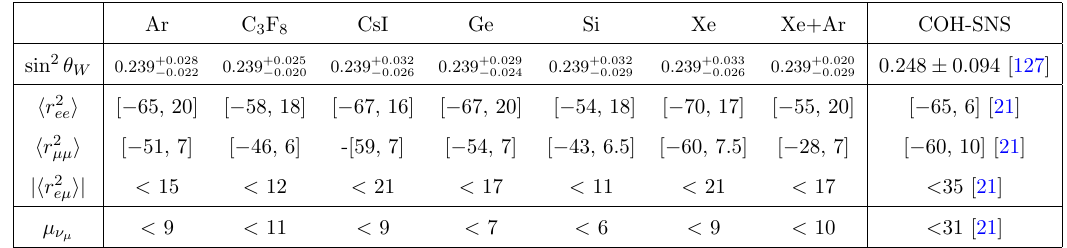
Table 3 . Allowed ranges at 90% C.L. for the weak mixing angle (given as best (cid:12)t charge radii for three (cid:13)avour projections (in units of 10 (cid:0) 32 cm 2 , and after marginalizing over the other two (cid:13)avour projections), and the (cid:23) (cid:22) magnetic moment (90% CL upper bound in units of 10 (cid:0) 10 (cid:22) B ). (cid:12)rst half of the data taking period and Ar during the other half. From the (cid:12)gure we